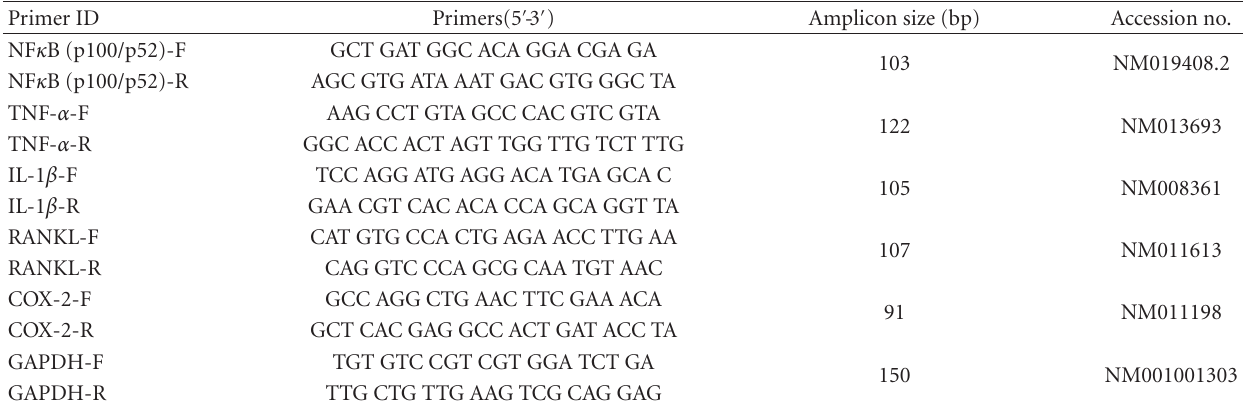
Table 1: List of primers used in real-time RT-PCR.